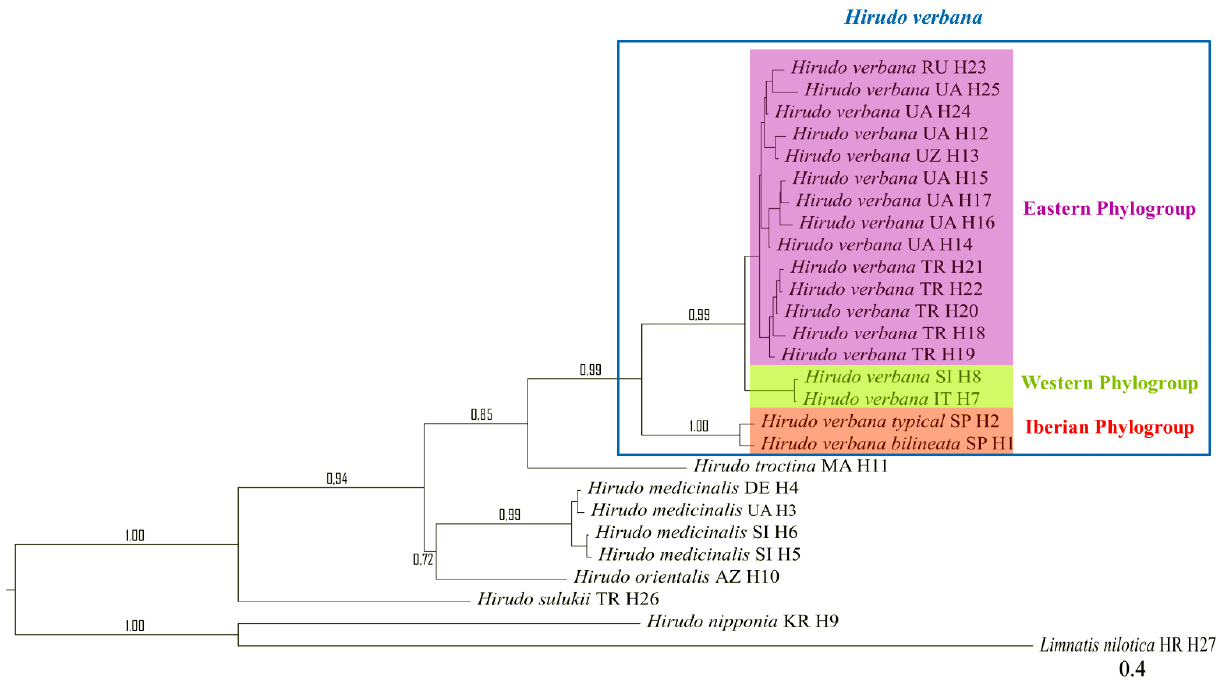
Figure 2. Phylogenetic relationship of Hirudo spp. based on Bayesian inference for the combined COI and 12S mitochon- drial markers.